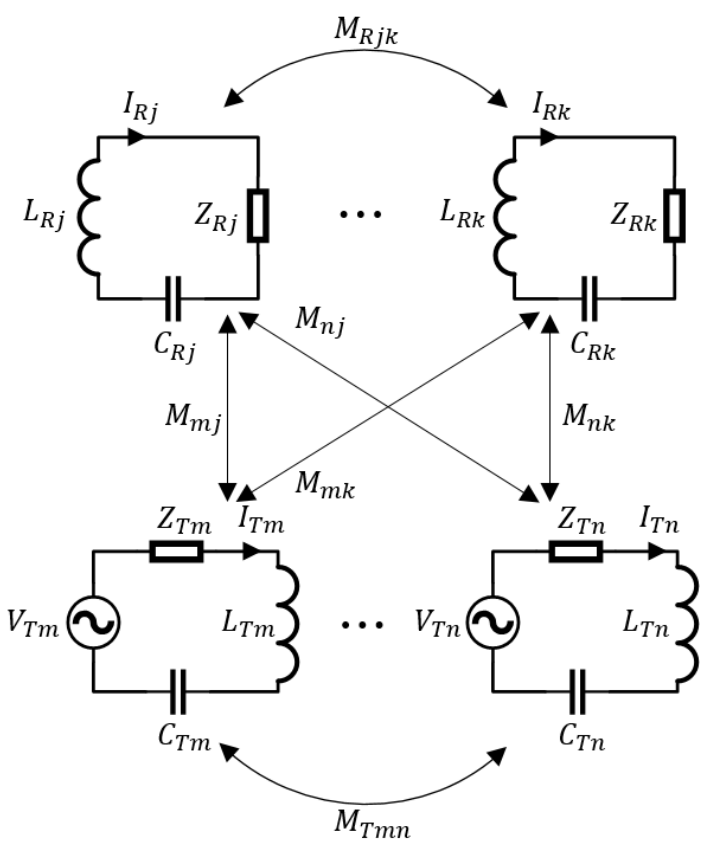
Figure 1. The configuration of n × k WPT